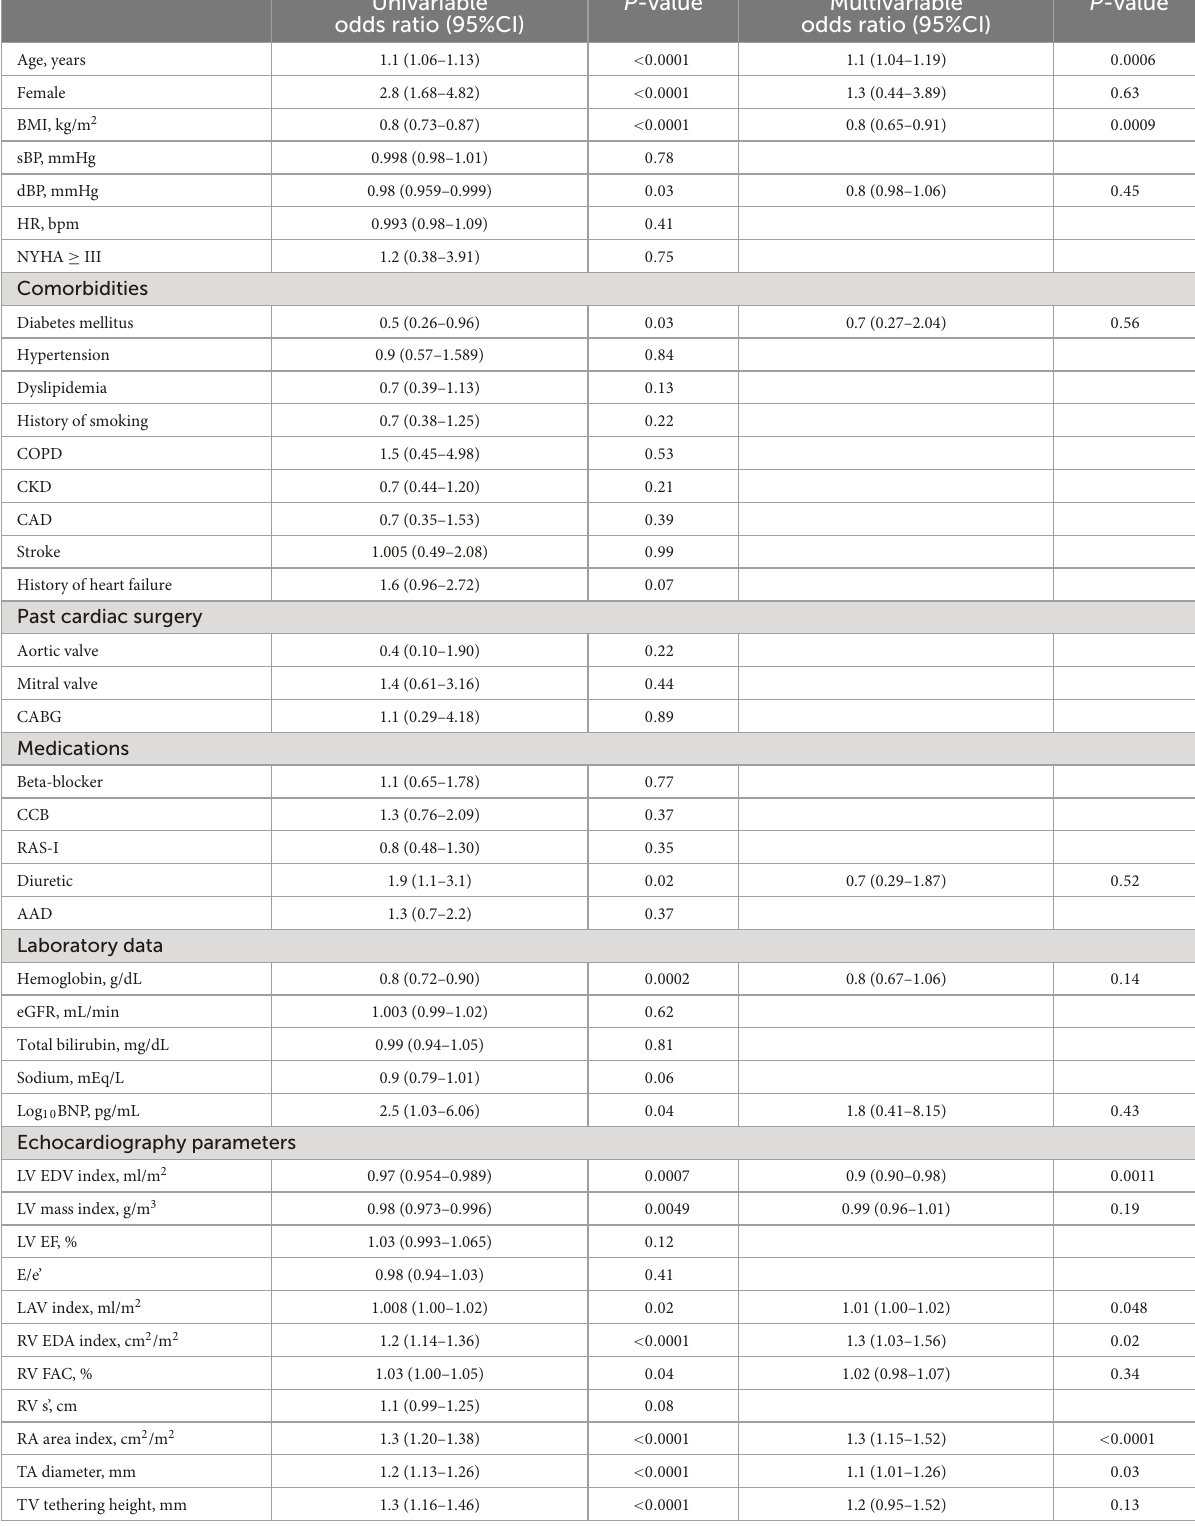
TABLE 3 Univariable and multivariable logistic regression analyses for significant